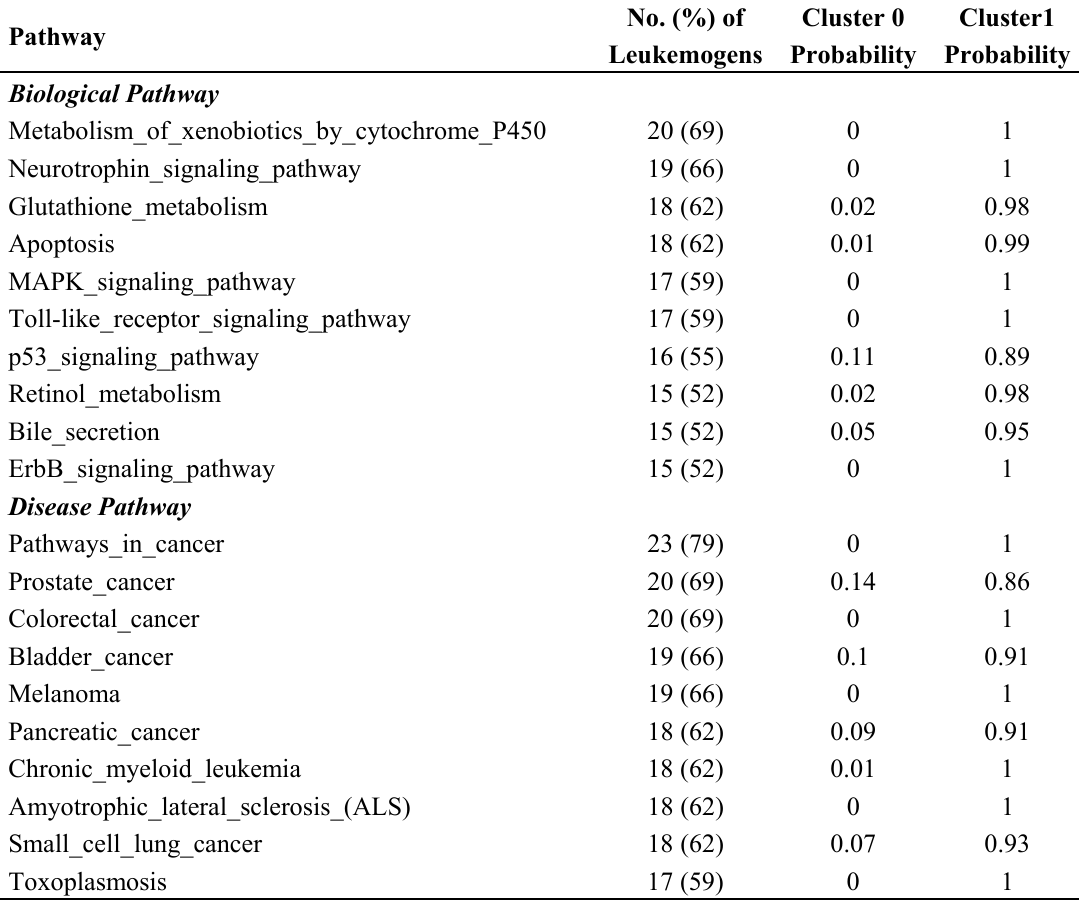
Table 1. Top 10 biological and disease KEGG pathways targeted by leukemogens and their respective membership probabilities in the two clusters in Figure